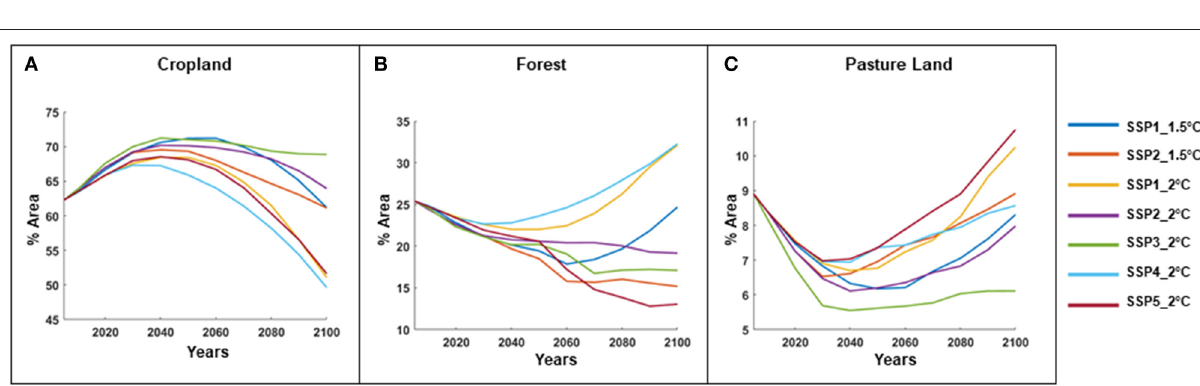
land use projections are then regionally disaggregated into 0.5